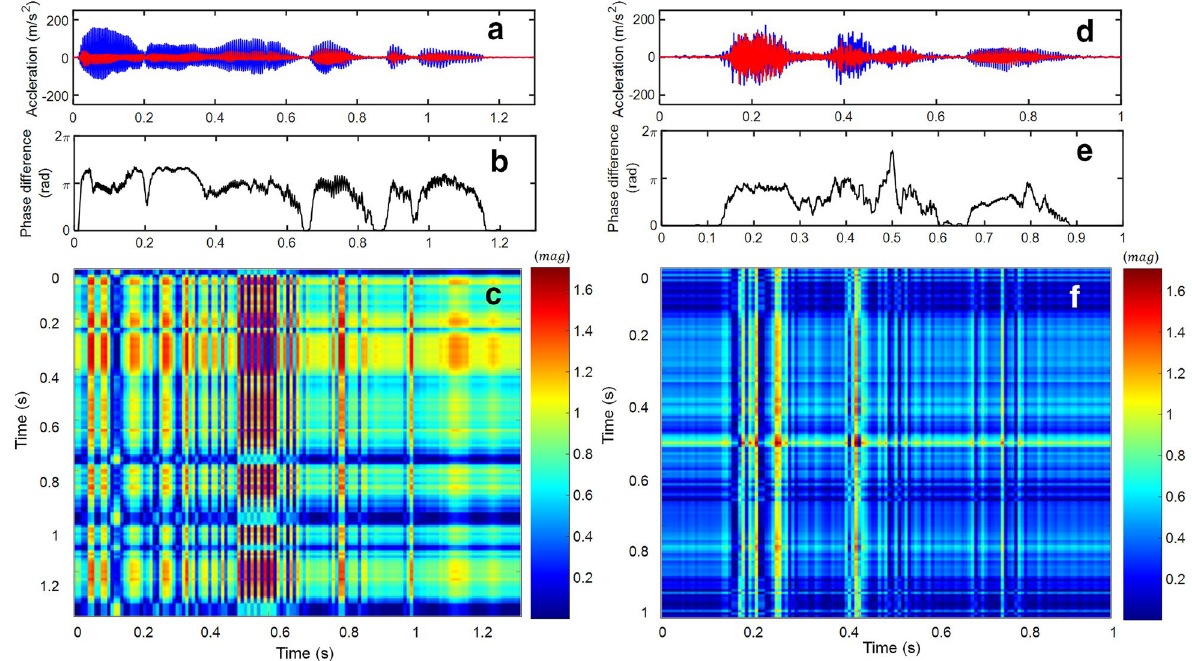
Figure 9. Cross-recurrence plot with HT for speech signals. ( a ) two acceleration signals of speech (Inha university), ( b ) their phase difference, ( c ) corresponding CRP (pixel size 134 × 134 ), ( d ) two acceleration signals of speech (happy house), ( e ) their phase difference, ( f ) corresponding CRP (pixel size 134 × 134 ).